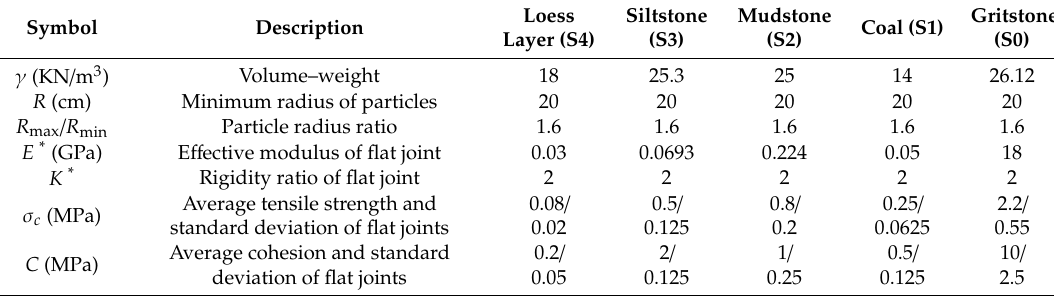
Table 1. Microscopic mechanical parameters of rock formation.